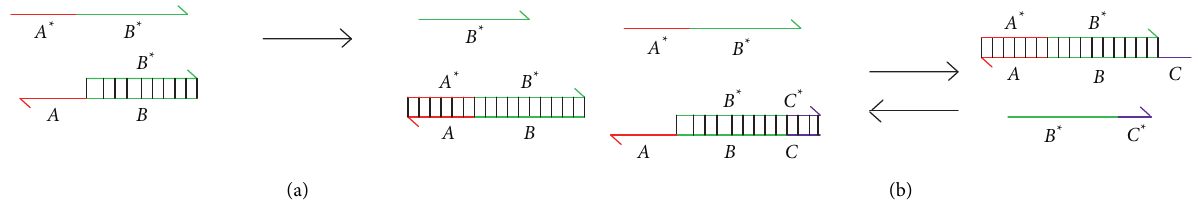
Figure 1: Principle of DNA strand displacement reaction. (a) Irreversible strand displacement reaction. (b) Reversible strand displacement reaction.